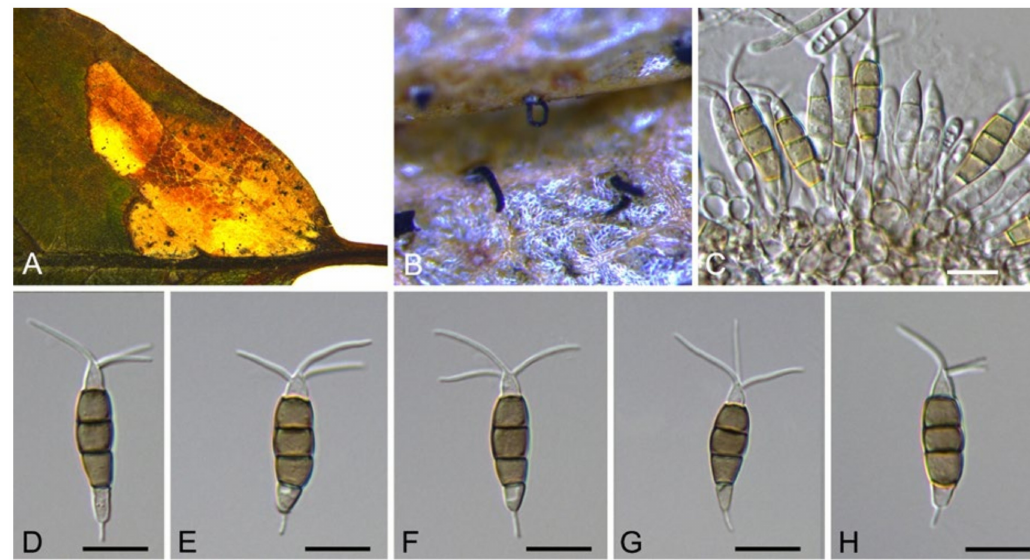
Figure 19. Pestalotiopsis kenyana (BJFC-S1784). ( A , B ) Conidiomata on the diseased leaves of Castanea mollissima ; ( C ) Conidio- genous cells giving rise to conidia; ( D – H ) Conidia. Scale bars: ( C – H ) = 10 µ